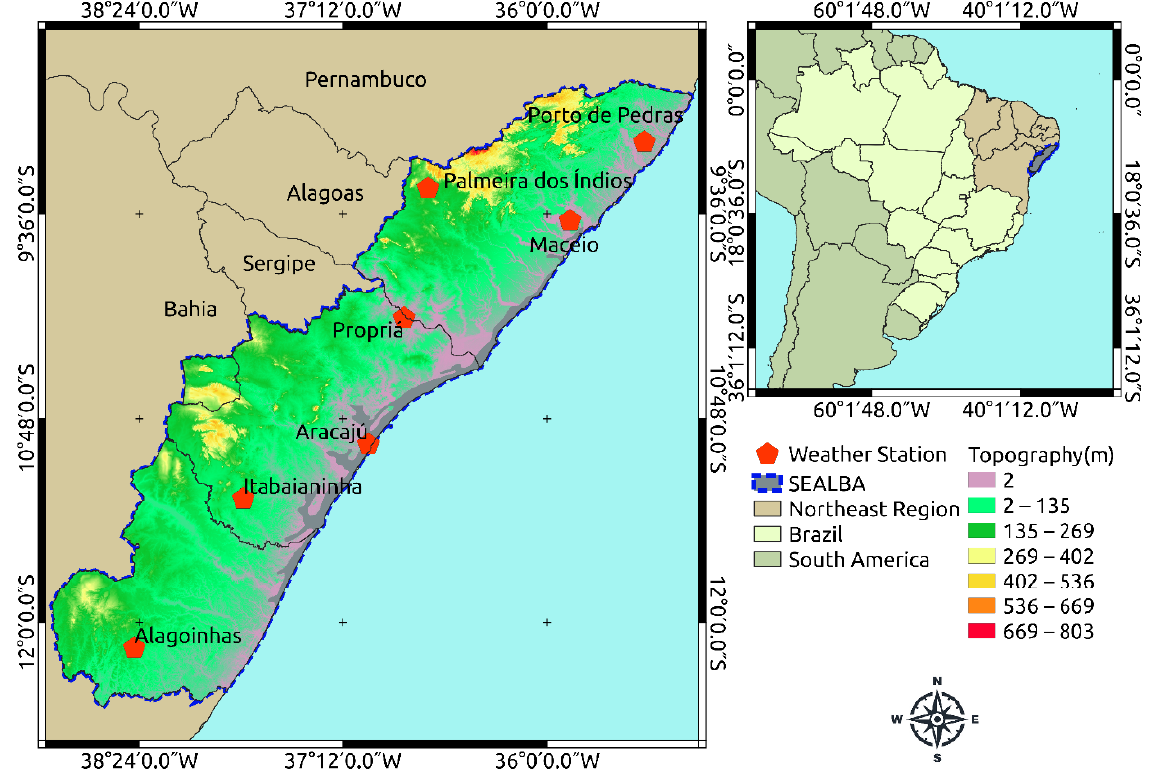
Figure 1. SEALBA map with highlighted topography, and proportion of its area in relation to NEB (beige), Brazil (yellow), and South America (grey). The INMET weather stations whose data were used in this study are identified by red points.